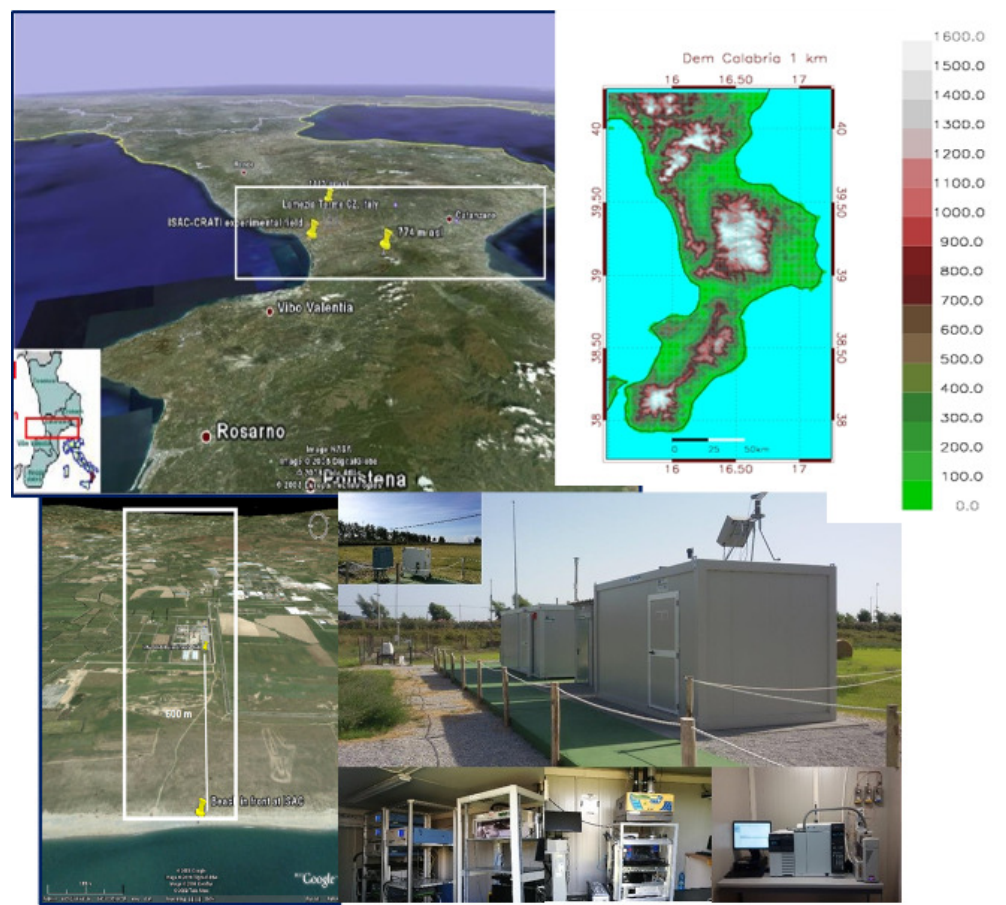
Figure 1. CNR-ISAC LMT GAW-WMO Regional site: localization, altitude Calabria region, observatory